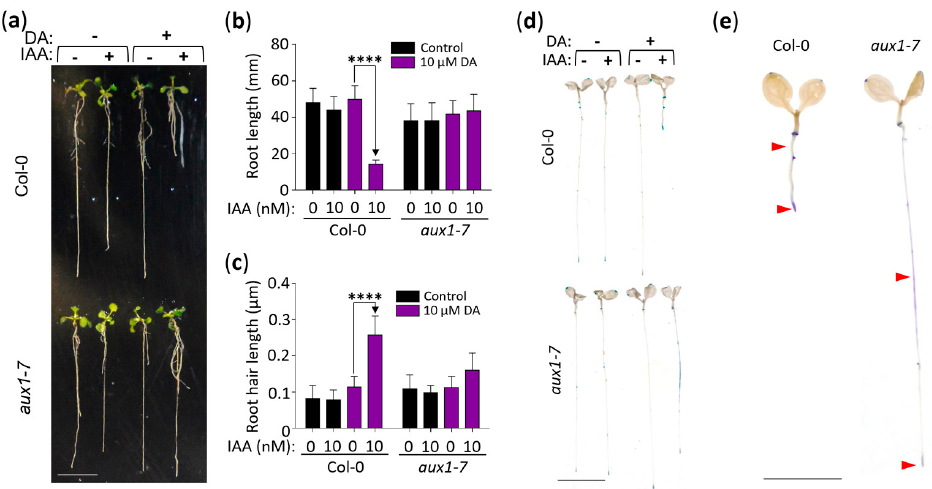
Figure 5. DA-induced IAA hypersensitivity depends on the auxin transporter AUX1. ( a ) Representative seedlings illustrating the differential impact of DA/IAA co-treatments on Col-0 and aux1-7 root growth. Col-0 and aux1-7 grown vertically for 11 days on the denoted media were transferred from the test plates to a fresh plate for photography. Scale: 10 mm. ( b ) Quantitative analysis of the differential impact of DA/IAA co-treatments on Col-0 and aux1-7 root length. Plants were grown as in ( a ) and were photographed, and root length was measured using ImageJ software. Data are presented as mean ± SD ( n ≥ 12; **** represents p < 0.0001; two-way ANOVA with Tukey’s post-test; multiple comparisons are demarked by one-way arrows). ( c ) Quantitative analysis of the differential impact of DA/IAA co-treatments on Col-0 and aux1-7 root hair length. Plants were grown as described in ( a ), and micrographs of root hairs were taken at 4× magnification. Root hair length was measured using ImageJ software. Data are presented as mean ± SD ( n ≥ 80; **** represents p < 0.0001; two-way ANOVA with Tukey’s post-test; multiple comparisons are demarked by one-way arrows). ( d ) DR5::GUS expression in DA/IAA co-treated plants is repressed in the aux1-7 background. Seedlings grown for 7 days on denoted supplemented media were removed from the media, stained, dehydrated, rehydrated in 50% glycerol, and photographed. Scale: 5 mm. ( e ) Digitally excised images of Col-0 and aux1-7 grown on media supplemented with 10 µM DA and 10 nM IAA. Red arrows point to areas of differential GUS staining. Scale: 5 mm.